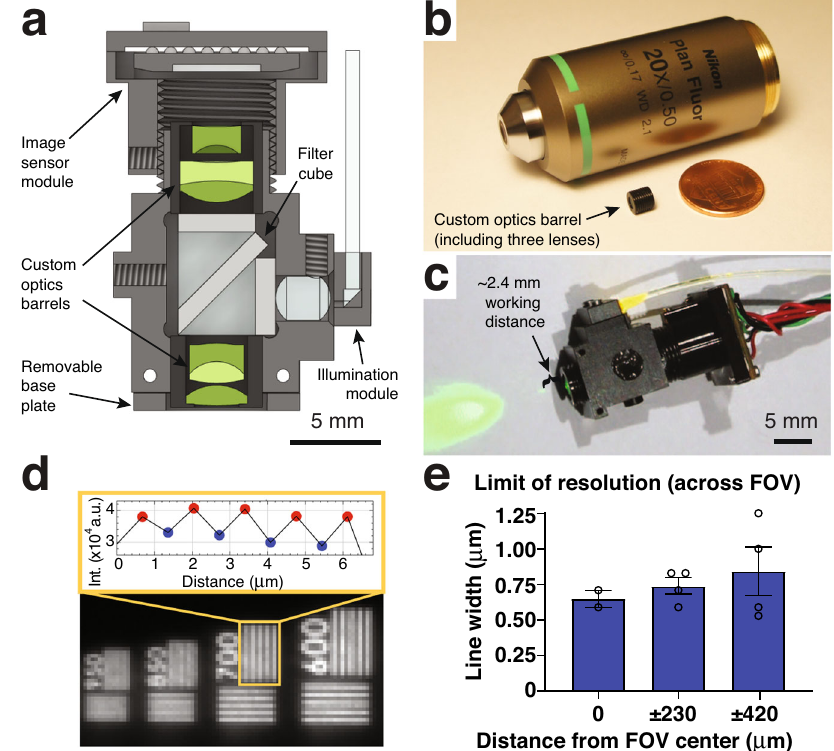
Fig. 1 | Wearable microscopes with long working distance custom-compound- microlenses for high-resolution measurements in behaving mice. a Cross- sectionofthewearablemicroscopeanditscustomcompoundmicro-optics(green) for high-resolution, multi-color, and long working distance imaging. Scale bar, 5mm. b Image of the <0.2grams objective barrel including three miniature lenses nextto a regularmicroscopeobjective and USAone-cent coin. c Imageofthe fully assembled device with ~2.4mm working distance for high-resolution imaging through intermediary optics. Scale bar, 5mm. d Bottom , image detail of a high-